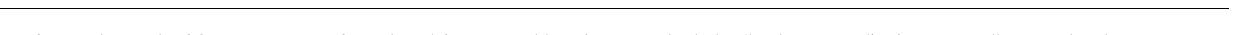
Figure 2 | Stat3 is required for centrosome clustering. ( a ) Western blot of Stat3 and tubulin (loading control) of BT-549 cells treated with Stat3 siRNAs (left). Quantification of the percentage of mitotic Stat3 siRNA-treated cells with declustered centrosomes (right; n ¼ 3 biological replicates, Z 600 cells per condition). Statistical significance was tested between non-specific siRNA-treated and Stat3 siRNA-treated groups with analysis of variance (ANOVA). ( b ) Quantification of inhibition of centrosome clustering in cells treated with the Stat3 inhibitors WP1066 and BBI-608 ( n ¼ 5 biological replicates, Z 1,000 cells per data point). Statistical significance was tested between untreated and compound-treated groups with ANOVA. ( c ) Quantification of the number of centriole pairs in Stattic-treated cells (left; n ¼ 4 biological replicates, 80 cells per condition). Statistical significance was tested between untreated and Stattic-treated groups with ANOVA. Immunofluorescence images of centriole pairs (centrin-2, green), tubulin (red) and DNA (Hoechst, blue) in a normal mitotic BT-549 cell (right). Inset: magnified image of centrin-2 stain. Arrows point to centrioles. Scale bar, 8 m m. ( d ) Quantification of the percentage of BT-549 cells with non-centrin-associated g -tubulin (left panel) and immunofluorescence images (right panels) of centrin-2 (green), g -tubulin (red) and DNA (Hoechst, blue). Scale bar, 5 m m. Arrows point to g -tubulin with centrin-2 staining, arrowheads point to g -tubulin staining without centrin-2 staining. Inset: magnified image of centrin-2 stain with arrows pointing to centrioles. n ¼ 4 biological replicates, 100 cells per condition. Statistical significance was tested between untreated and Stattic-treated groups with Student’s T -test. ( e ) Analysis of supernumerary centrosomes in Stat3 (cid:2) / (cid:2) ErbB2 induced mouse mammary tumours. The percentage of cells with supernumerary centrosomes was quantified as described in Experimental Procedures (left panel; n ¼ 4 mice per condition, 80 cells per condition). In separate scoring, the percentage of supernumerary centrosome cells with clustered or declustered centrosomes was quantified (right; n ¼ 4 mice per condition, 80 cells per condition). Statistical significance was tested between wild-type and Stat3-knockout groups with Student’s T -test. * P o 0.05; ** P o 0.01; *** P o 0.001. Error bars represent